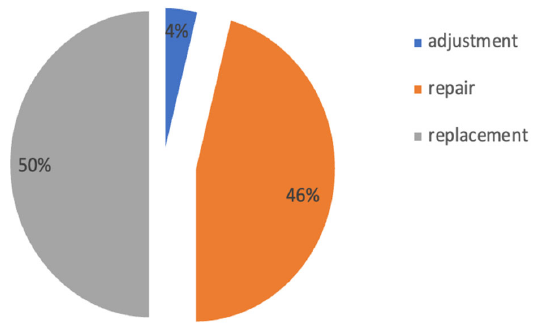
Figure 2. Classi fi cation of damage according to the time taken to repair it.